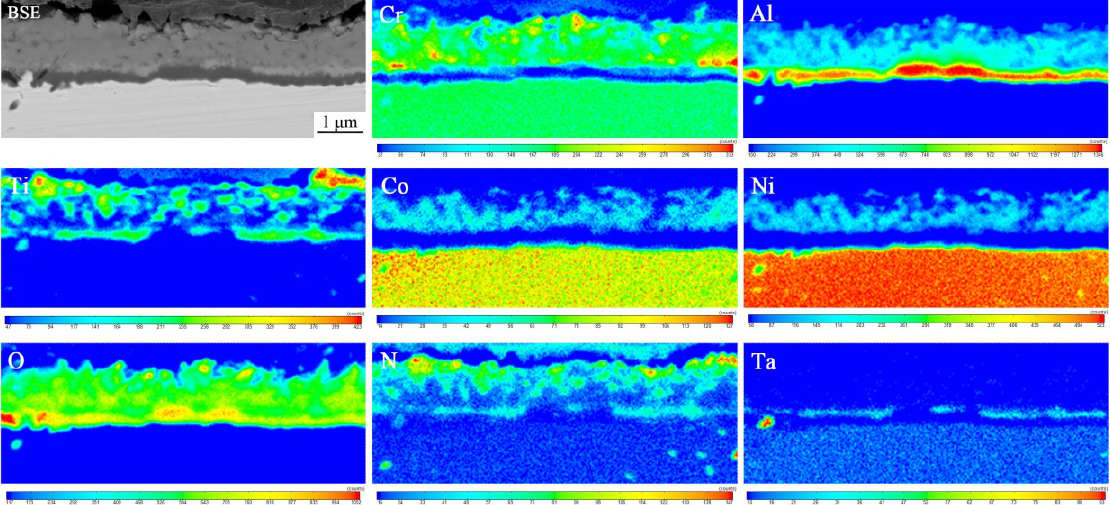
Figure 7. Secondary electron micrograph and corresponding X-ray micrograph of the E7 alloy after oxidation at 1000 °C for 4 h.